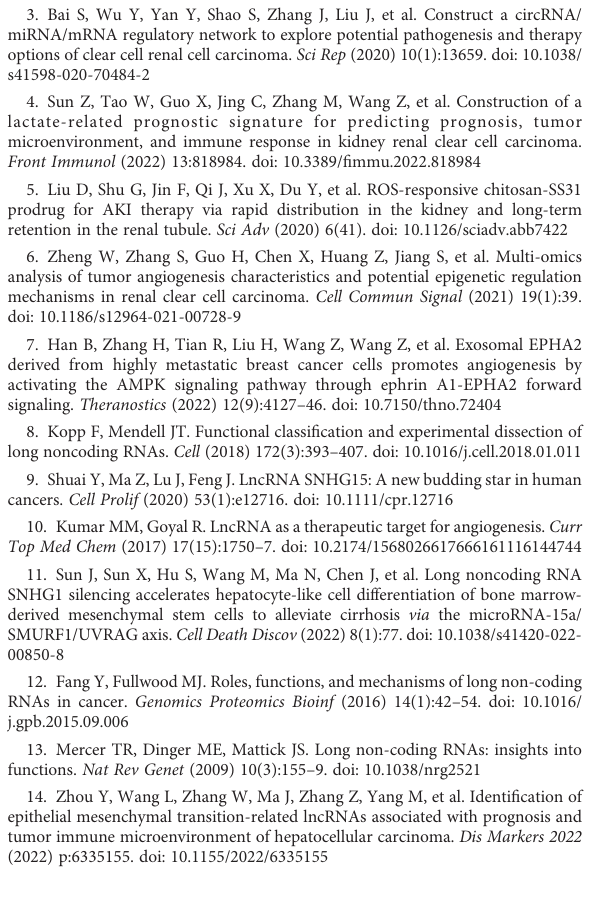
SUPPLEMENTARY FIGURE 3 Distribution of tumor-in fi ltrating immune cells (TICs) in KIRC and correlation analysis. (A) Bar plot showing the distribution of TICs in KIRC. (B) Correlation analysis of the 21 TICs in KIRC.